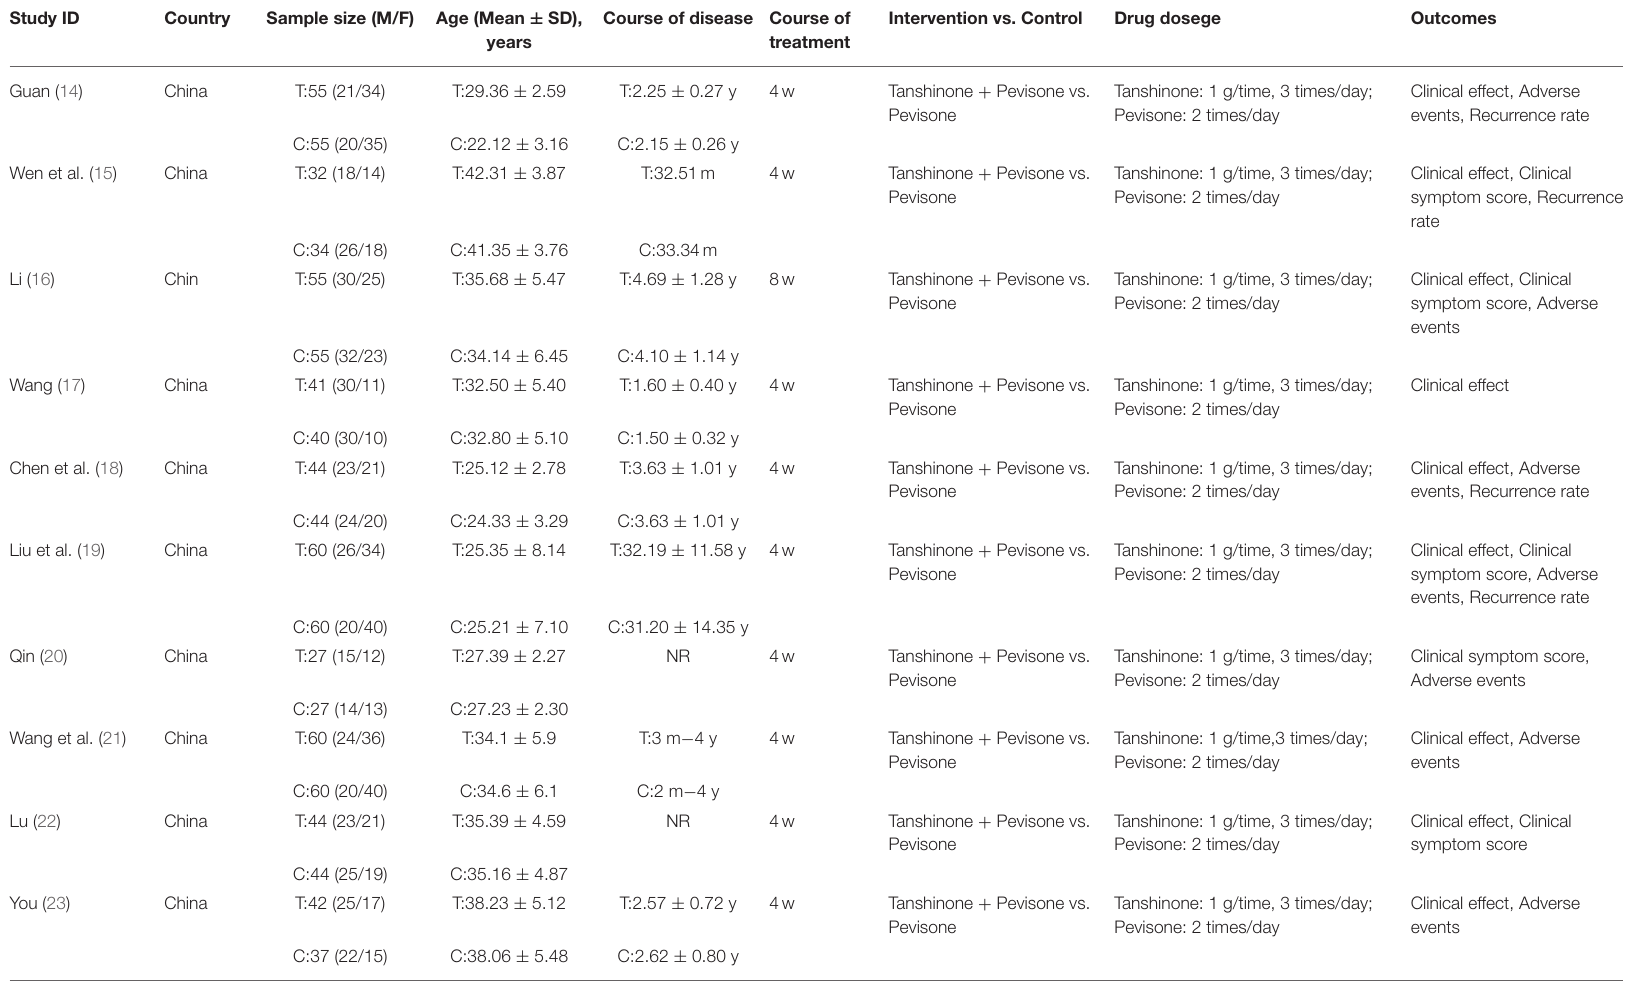
TABLE 1 | Characteristics of the included trials. Study